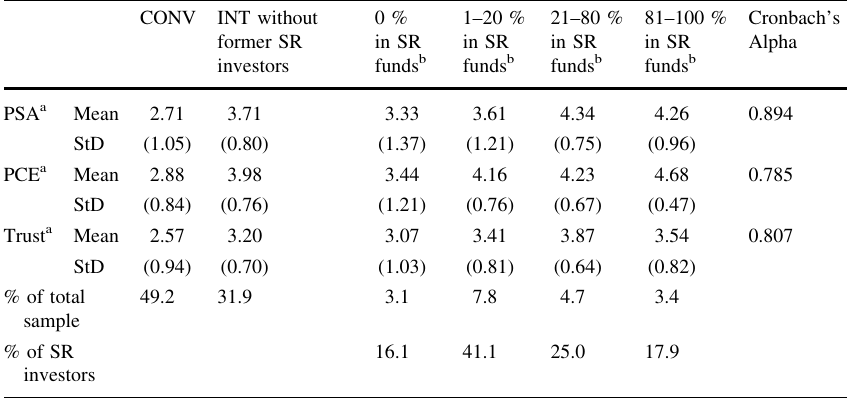
Table 2 Pro-social attitudes (PSA), perceived consumer effectiveness (PCE), trust in SR funds and their connections to the percentage of capital invested in SR